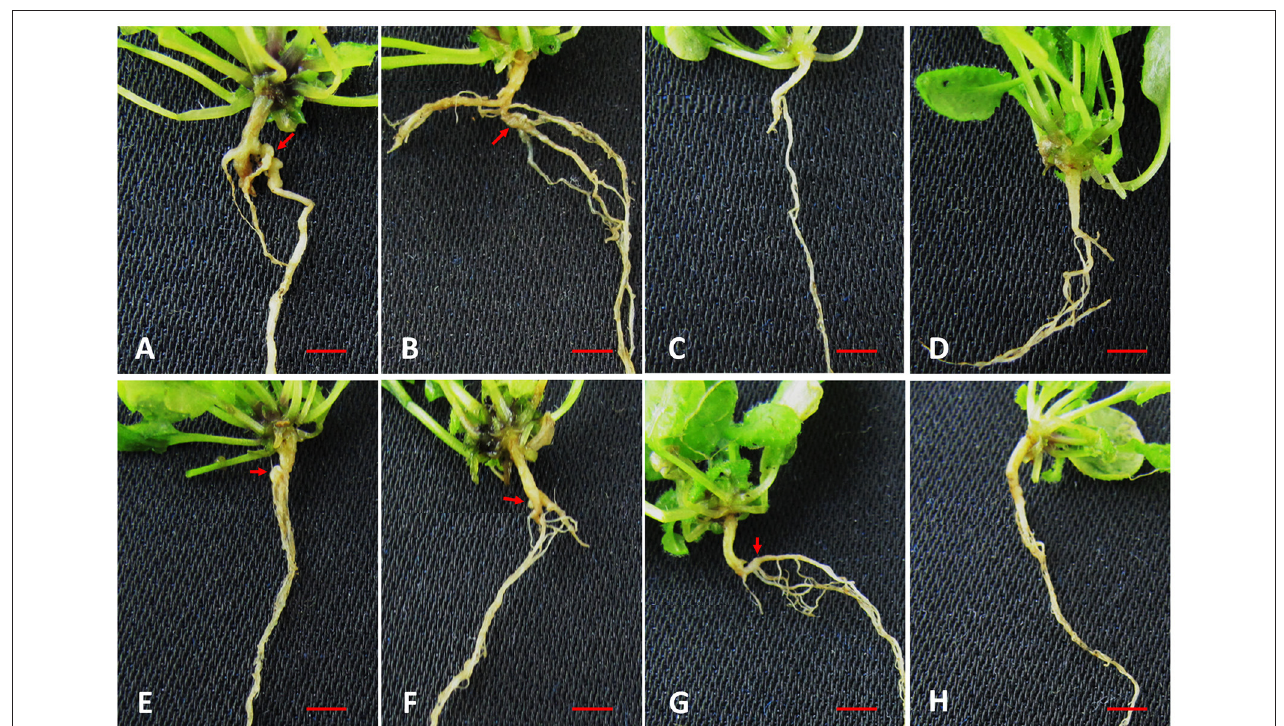
FIGURE 9 | The clubroot symptoms of Arabidopsis Col-0 and mutants infected by P. brassicae. Clubroot disease in A. thaliana ecotype Col-0 and mutants 18 days after inoculation with P. brassicae . (A) AT5G66590 mutant (SALK_121768); (B) AT3G04720 mutant (SALK_082089C); (C) AT1G50060 mutant (SALK_033410); (D) AT3G12500 mutant (SALK_028588C); (E) AT4G36000 mutant (SALK_108883); (F) AT2G19990 mutant (SALK_014249C); (G) AT1G73620 mutant (SALK_100586C); (H) Col-0. Bar = 0.5